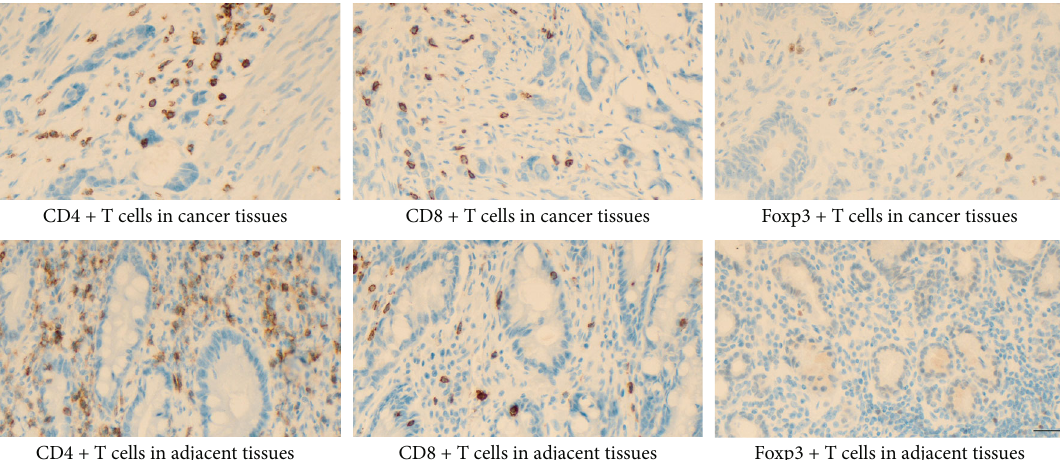
Figure 2: In fi ltration of CD4 + T, CD8 + T, and Foxp3 + T cells in malignant tissues and normal adjacent tissues. CD4 + T plus CD8 + T cells were stained in yellow or brownish yellow on the cell membrane or cytoplasm, and the nuclear was brown or tan as Foxp3 + T cells ( × 400), scale bar: 20 μ m.